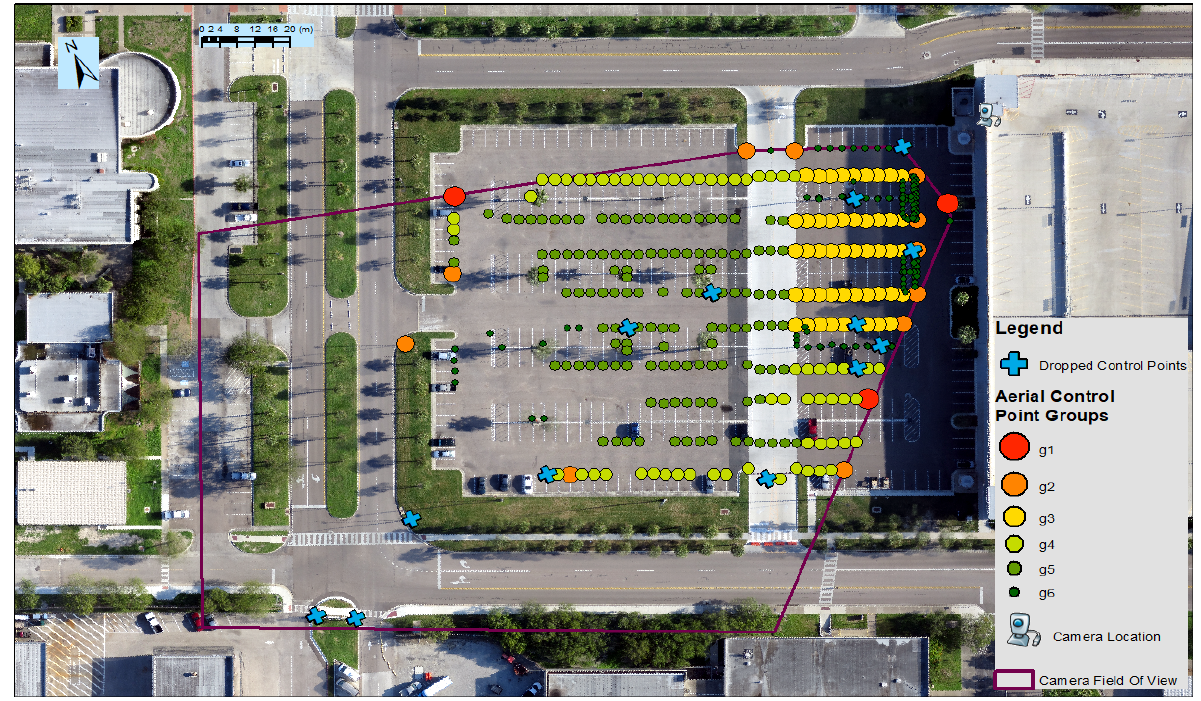
Figure 5. 399 manually annotated point pairs, with coordinates shown on the aerial image. Regis- tration was tested for variance over successively larger sets of points, determined by group number. Points which were regularly dropped during the computation process to reduce transformation error are visualized as blue